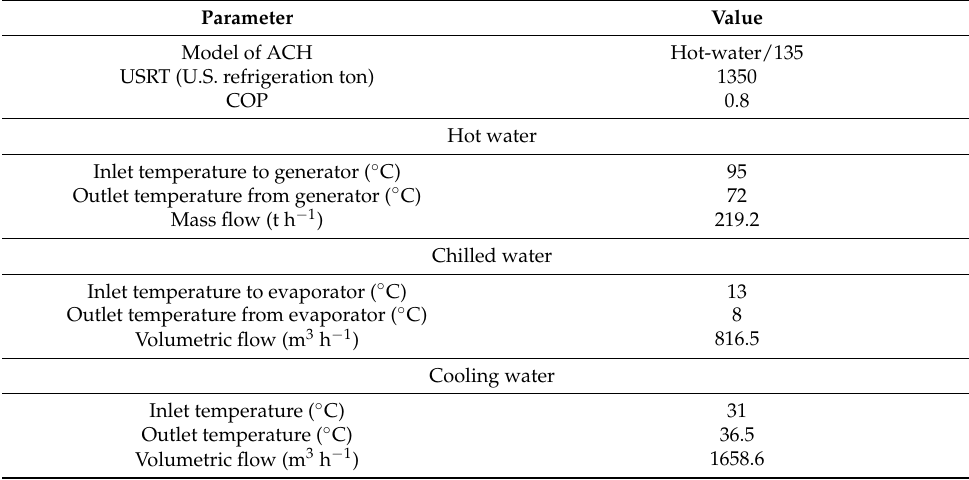
Table A4. Parameters of absorption cooler (ACH) placed after first compression stage. COP: coeffi-